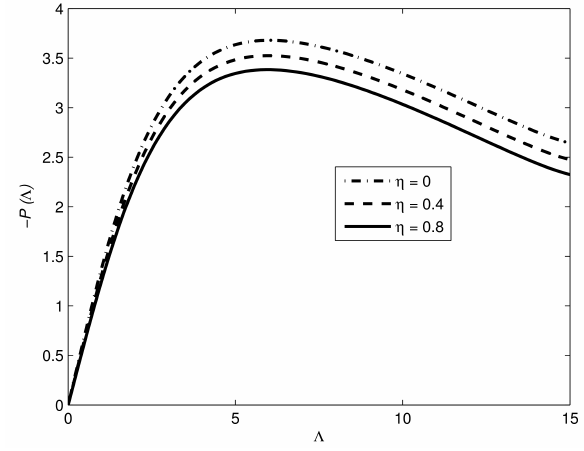
Figure 17: Effect of η on − P ( Λ ) keeping ζ = 0.2 , Pr = 6.8 , Br = 1 , Re = 2950 , C 1 = C 2 = C 3 =